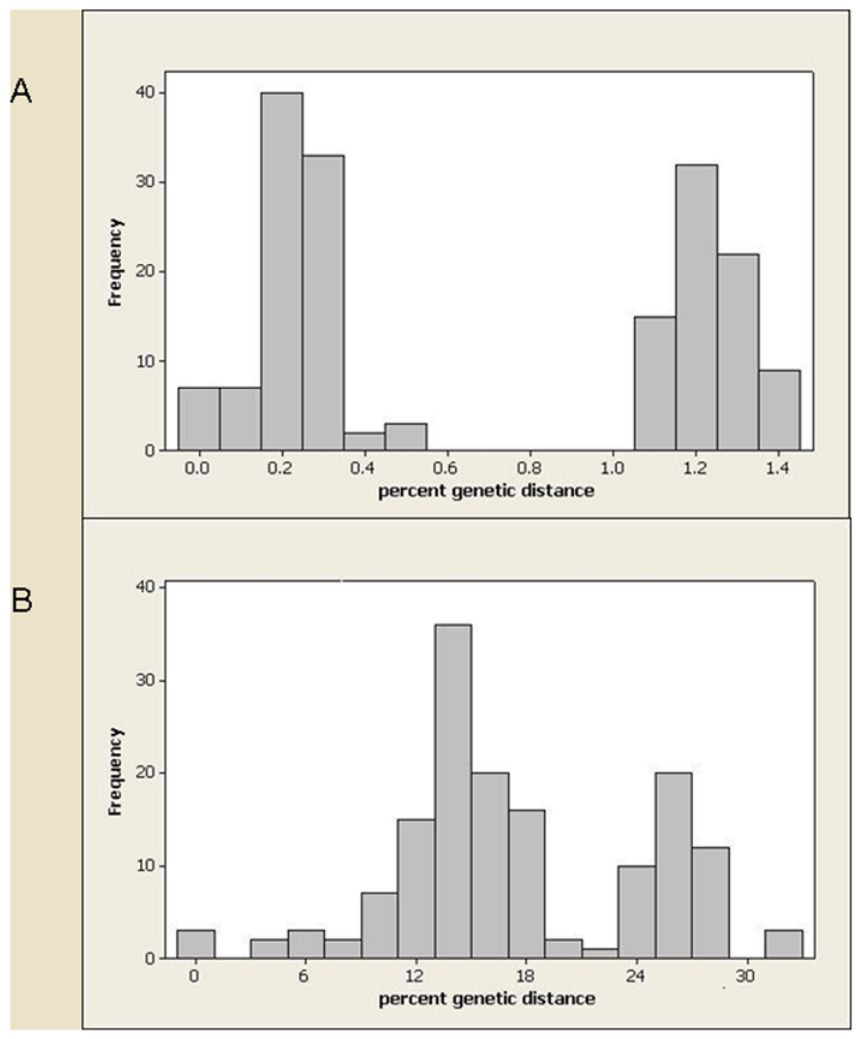
Figure 5. Distribution of pairwise genetic distance for B.lusitaniae housekeeping genes (A) and ospC (B).